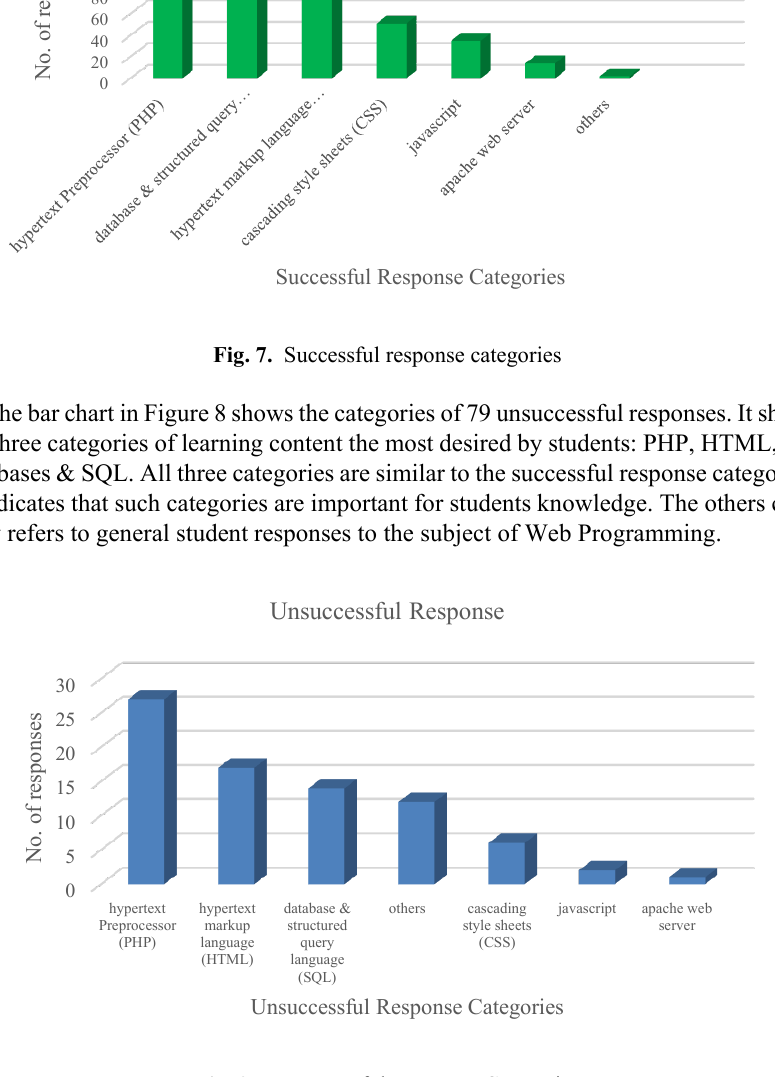
Fig. 8. Unsuccessful Response